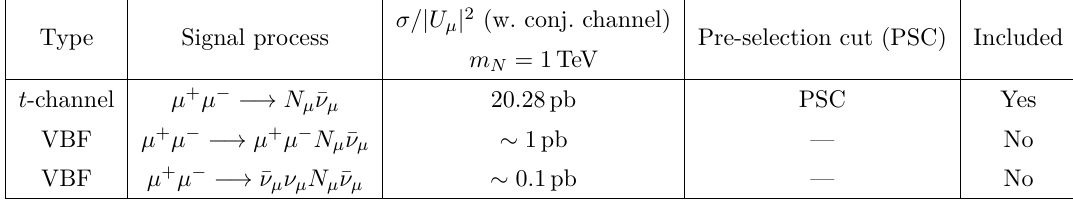
Table 3 . The signal rate for N µ at 10 TeV. The cross section includes the charge conjugate